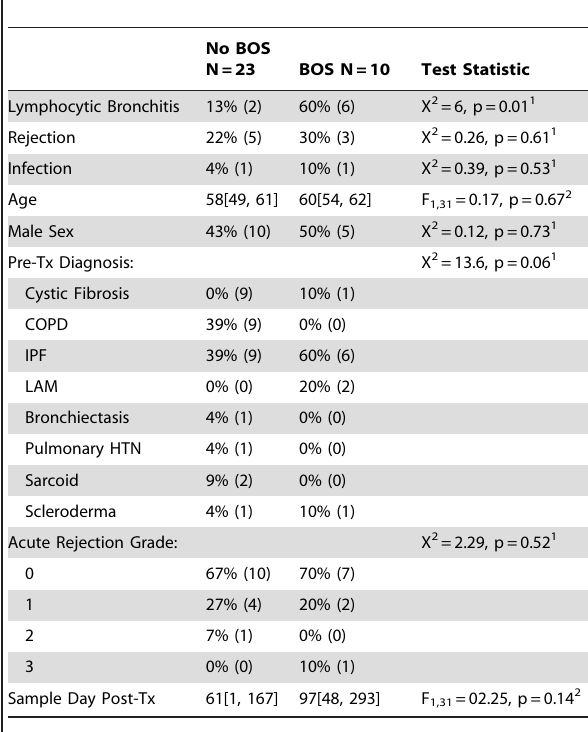
Table 1. Descriptive statistics by BOS outcome for